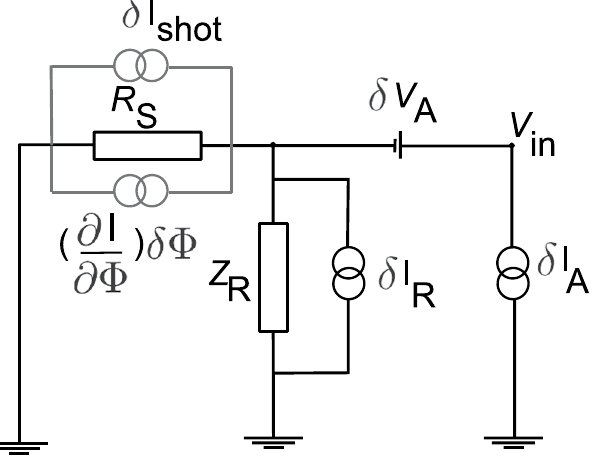
Figure 7. Circuit model for evaluating the voltage fluctuations referred to the amplifier